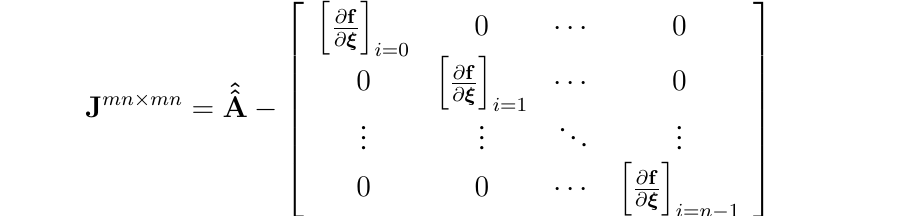
= 0 . 2 s, τ = τ = 2 s, τ = 0 . 1 s and A AP BP B